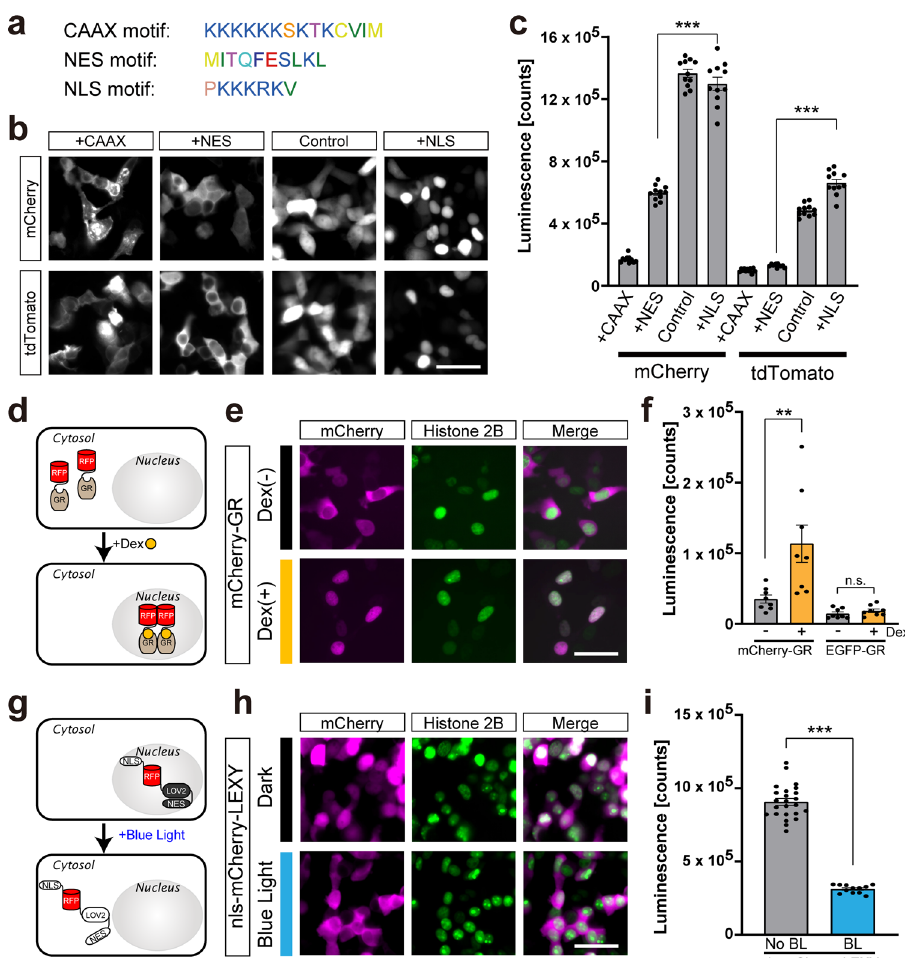
Fig. 3 Cellular localization and recombinase activity of Cre-DOR. a Amino acid sequences of the CAAX motif (membrane localization signal), NES motif (nuclear export signal), and NLS motif (nuclear localization signal). b Fluorescent images of mCherry or tdTomato with or without (Control) each localization motif. Scale bar = 50 μ m. c Luciferase assay of Cre-DOR N6C1 or Cre-DOR N8C8 with RFPs having different cellular localizations. Data are means ± SEM. Statistical analyses were performed by one-way ANOVA followed by Tukey ’ s multiple comparison test ( n = 11, *** P < 0.001). d Schematic representation of ligand-induced translocation of RFPs from the cytosol to the nucleus. Dexamethasone (Dex) induces translocation of GRs upon its binding. e Fluorescent images of mCherry-GR without or with Dex (1 μ M, 1 h). Scale bar = 50 μ m. f Luciferase assay of Cre-DOR N6C1 activity targeting mCherry-GR without or with Dex (1 μ M, 24 h). Data are means± SEM. Statistical analyses were performed by one-way ANOVA followed by Tukey ’ s multiple comparison test ( n = 8, ** P < 0.01). g Schematic representation of light-induced translocation of RFPs from the nucleus to the cytosol. The LEXY domain consists of a modi fi ed AsLOV2 domain with NES. Blue light induces exposure of the NES and results in translocation of RFPs. h Fluorescent images of nls-mCherry-LEXY with or without blue light illumination (465 nm, 3.7 W/m 2 ). Scale bar = 50 μ m. i Luciferase assay of Cre-DOR N6C1 activity targeting nls-mCherry-LEXY without or with blue light illumination ( n = 24, 12). Data are means± SEM. Statistical analyses were performed by Student ’ s t -test (*** P < 0.001). In Fig. 3e, h, nuclei are visualized by fl uorescence from H2B-BFP that was co-transfected with mCherry-GR or